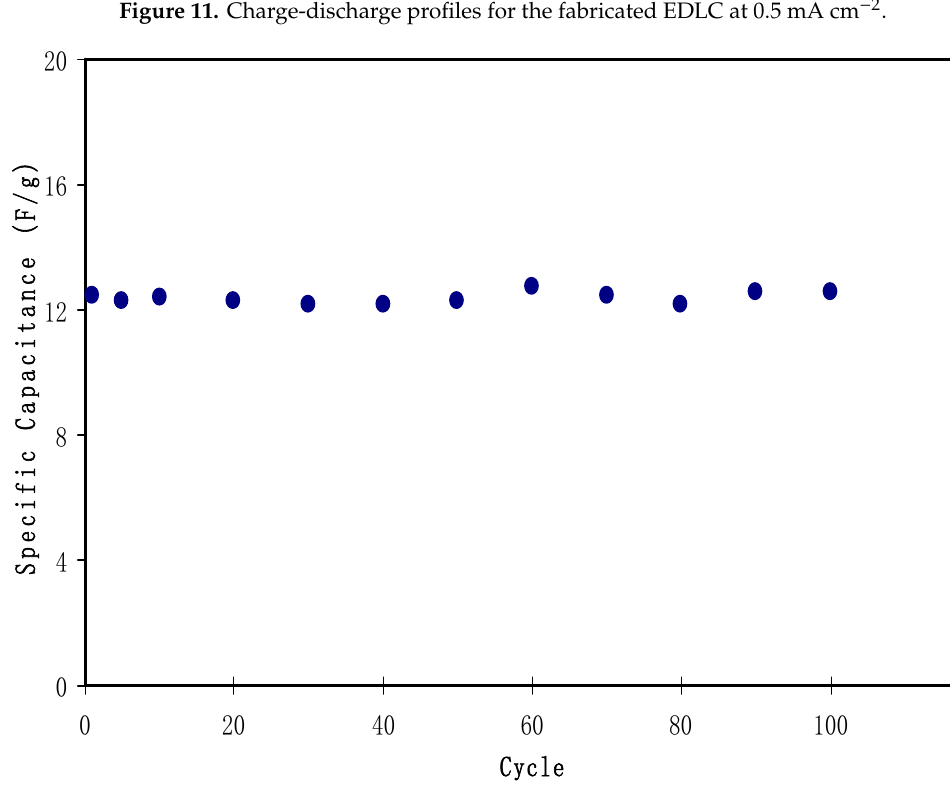
Figure 12. Specific capacitance of the fabricated EDLC for 100 cycles.